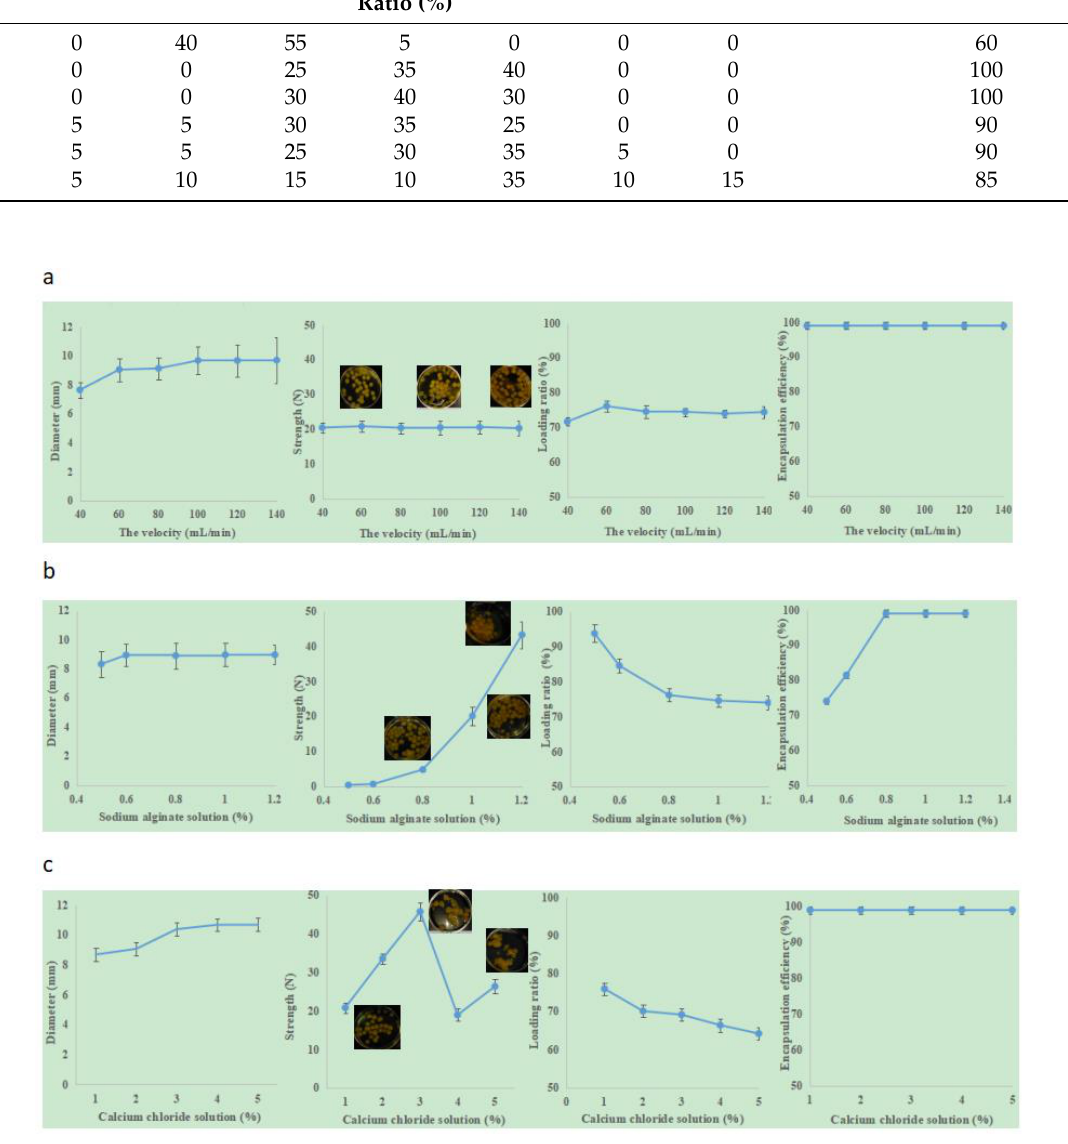
The Velocity (mL/min)